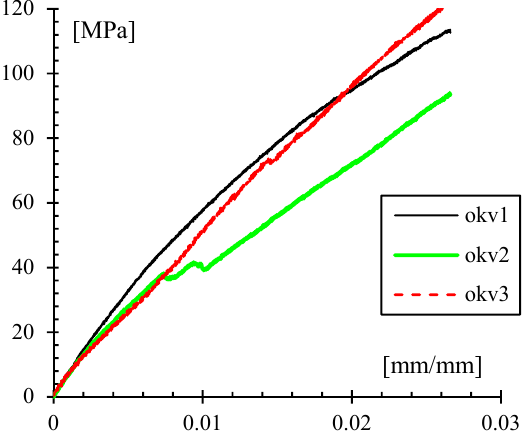
Figure 8. Stress-strain plot in four-point bending for Onyx ® reinforced with Kevlar.